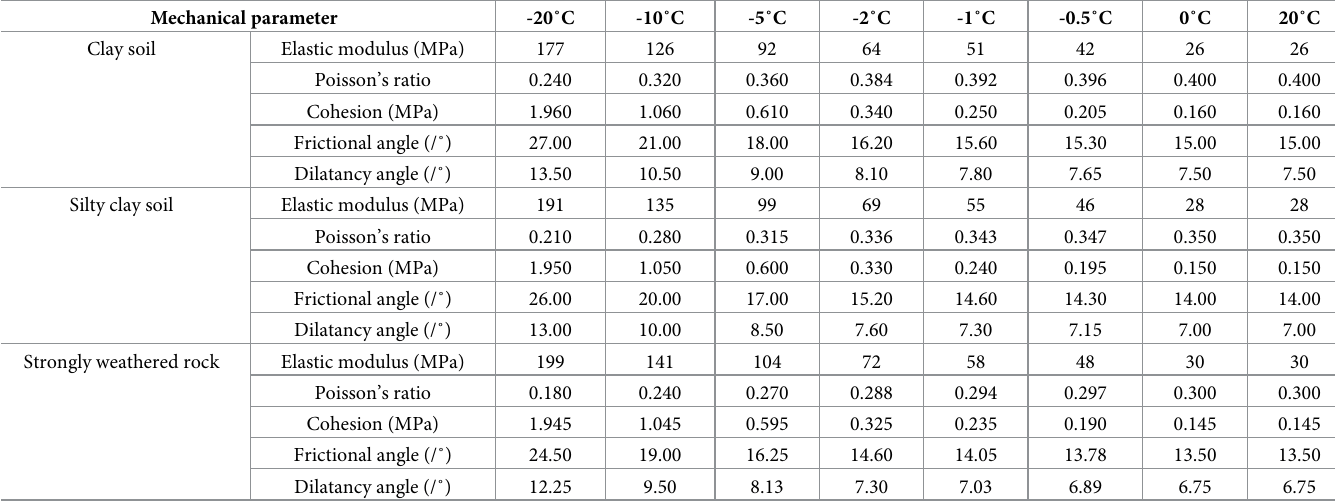
Table 4. Mechanical parameters of the strongly weathered rock, silty clay soil, and clay soil.